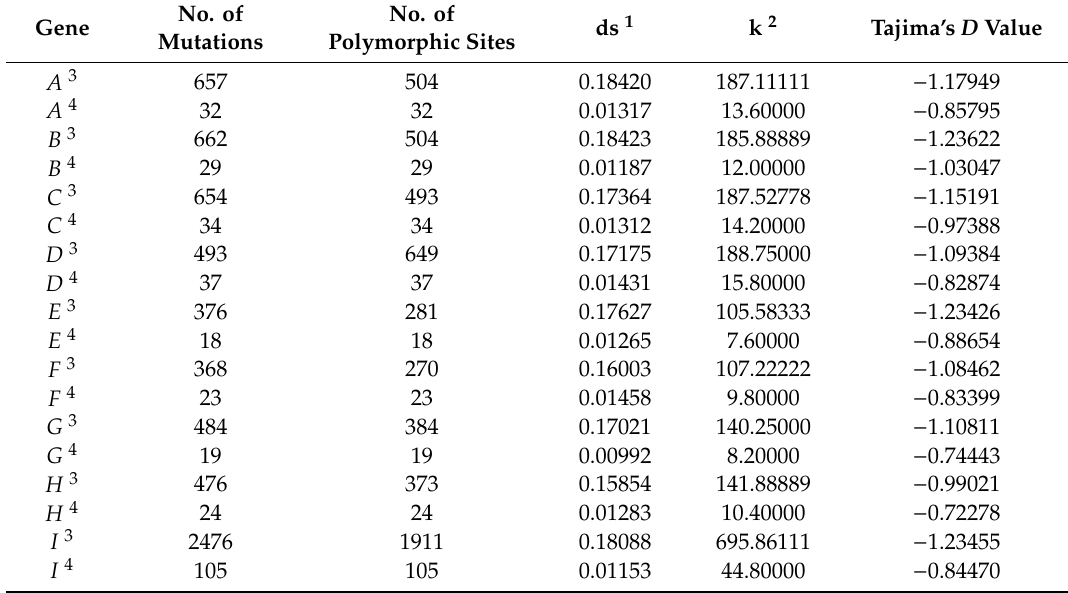
Table 6. Descriptive Analysis of Nucleotide Sequence Data for Concatenated Sequences Used in Multilocus Sequence Analysis (MLSA)